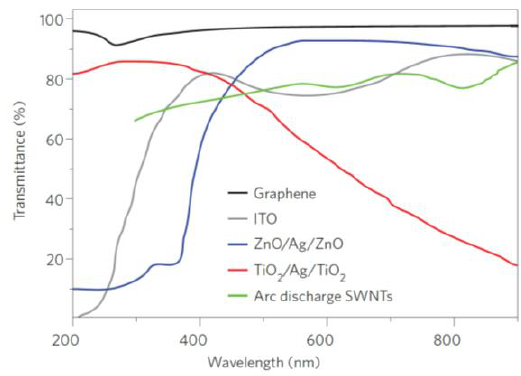
Figure 11. Transmittance of different transparent conductors: Graphene, indium tin oxide (ITO), ZnO/Ag/ZnO, TiO 2 /Ag/TiO 2 and arc discharge single-walled nanotubes. Reprinted from [119] with permission from Nature Photonics.